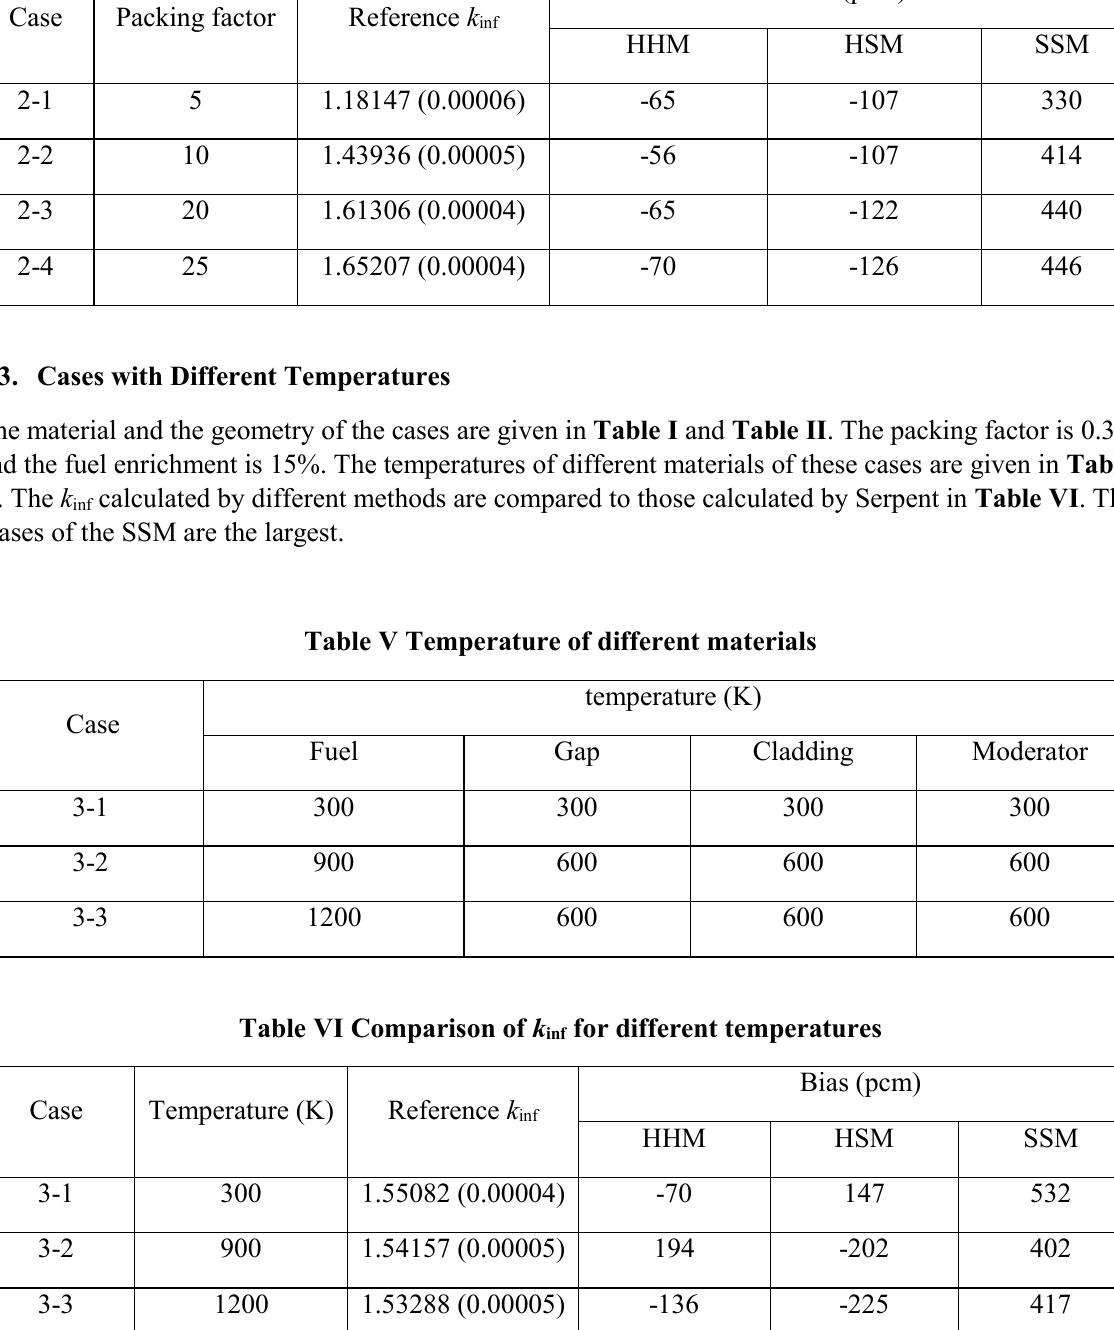
Table IV Comparison of k